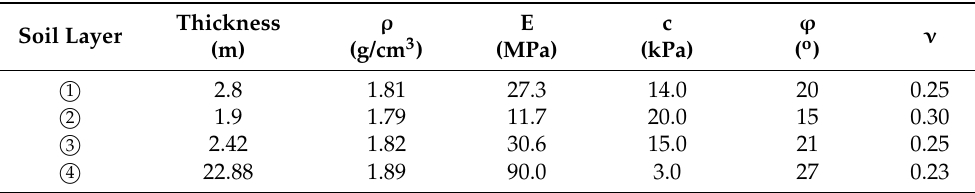
Table 5. The calculation parameters of the soil. Thickness Soil Layer